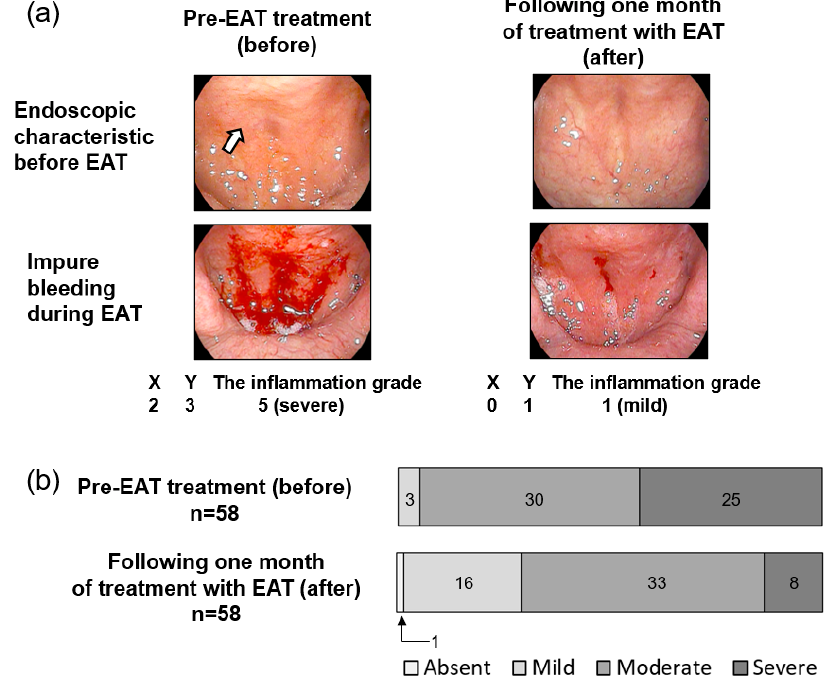
Figure 3. Effect of epipharyngeal abrasive therapy (EAT) for the treatment of chronic epipharyngitis. ( a ) Trans-nasal endoscopic photographs of the epipharynx in a patient. Left panel shows the epipharynx pre-EAT treatment (before). Right panel shows the epipharynx following one month of treatment with EAT (after). The white arrow indicates cobblestone-like granular changes. The inflammation grade = (X) the score of inflammation due to endoscopic characteristic + (Y) the score of impure bleeding. ( b ) Changes in inflammation grade due to EAT. All patients were treated with EAT once a week. The upper panel shows the inflammation grade at the first visit. The lower panel shows the inflammation grade following one month of treatment with EAT. The inflammation grade of chronic epipharyngitis was scored on a scale of 0–6 (0: absent, 1–2: mild inflammation, 3–4: moderate inflammation, 5–6: severe inflammation). Table 1. The significance of the difference and the effect sizes between pre-epipharyngeal abrasive therapy (EAT) treatment (before) and following one month of treatment with EAT (after). Following One Month of Significance Pre-EAT Treatment Treatment of Differ- (before) with EAT (after) ence